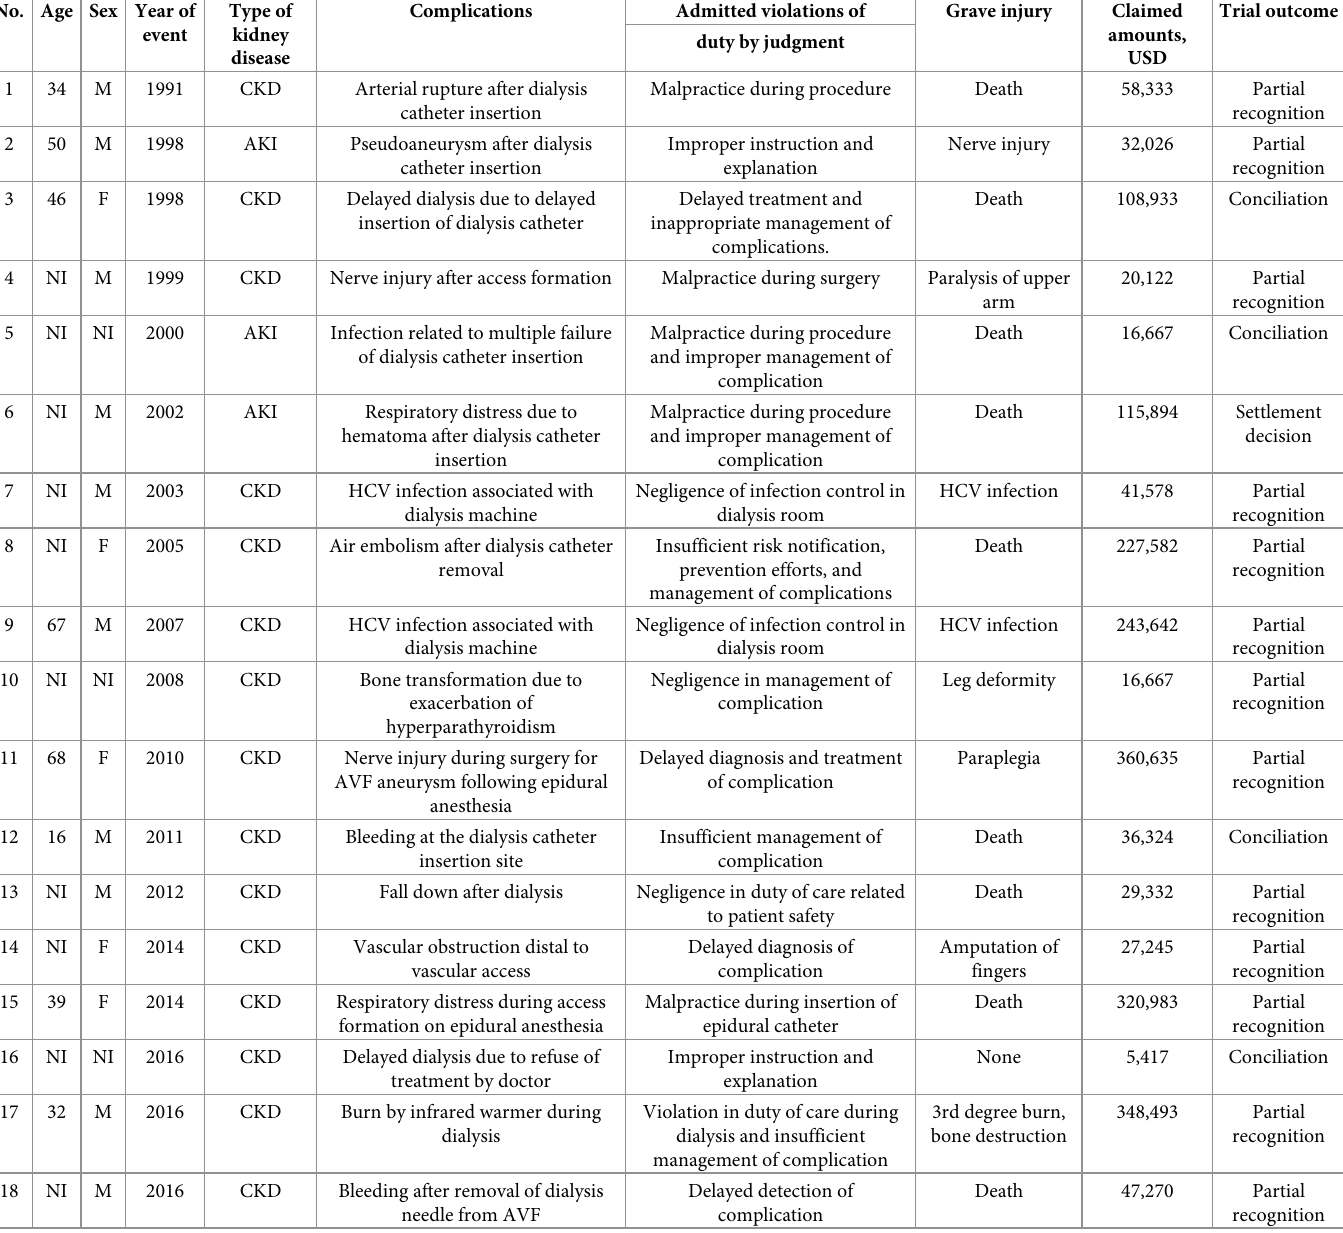
Table 3. Summary of general information of the lawsuits which recognized